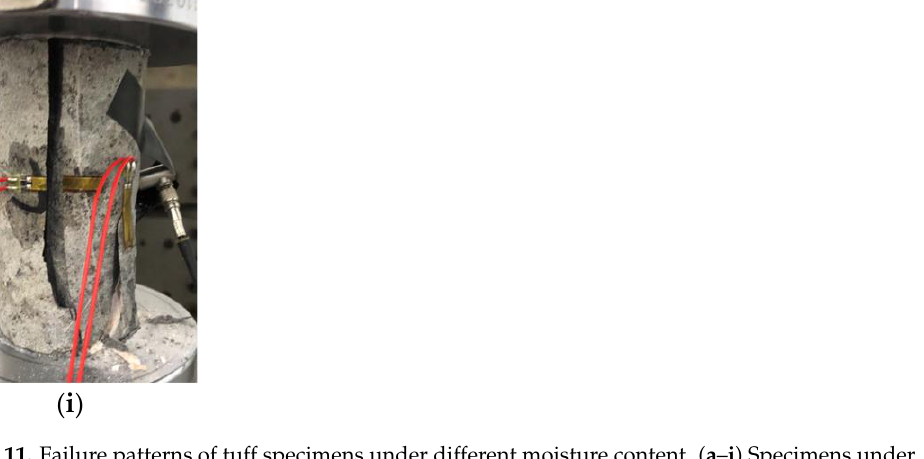
Figure 11. Failure patterns of tuff specimens under different moisture content. ( a – i ) Specimens under different moisture content.